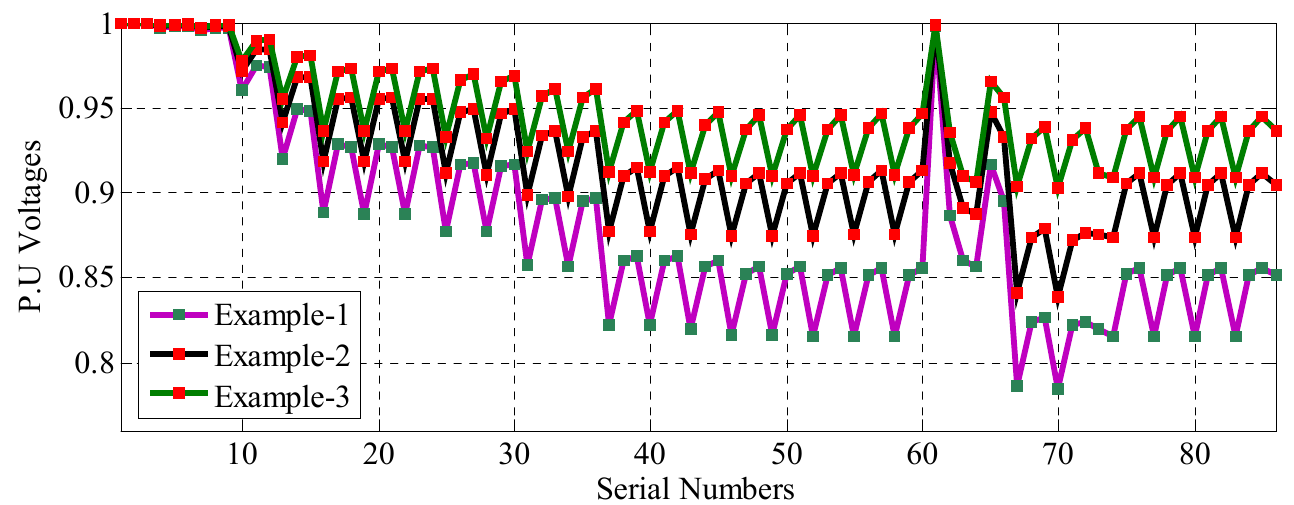
Figure 9. IEEE-34 bus URDN.